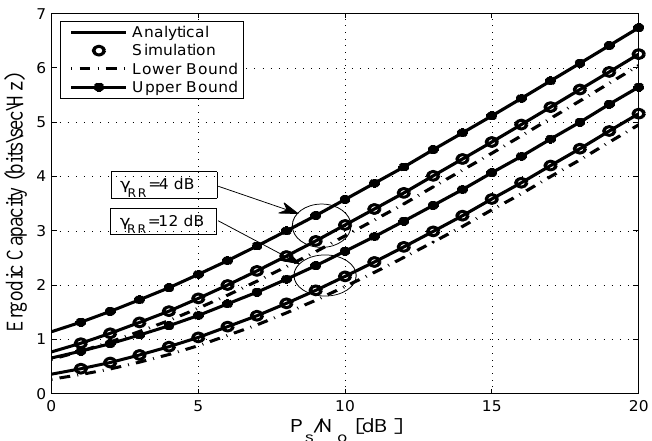
Figure 4. Ergodic capacity vs. P S / N o for different values of γ RR for m ij = 2, d SR = 0.45, d RD = 0.55, γ ID = 5 dB, and η =